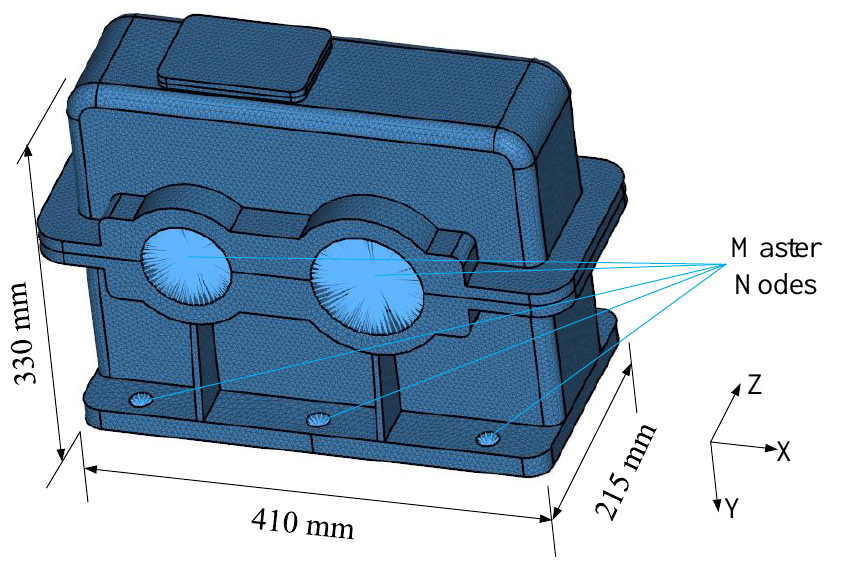
Figure 3. Revised Figure 3. The housing FE